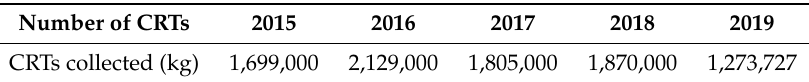
Table 1. CRTs collected over time.